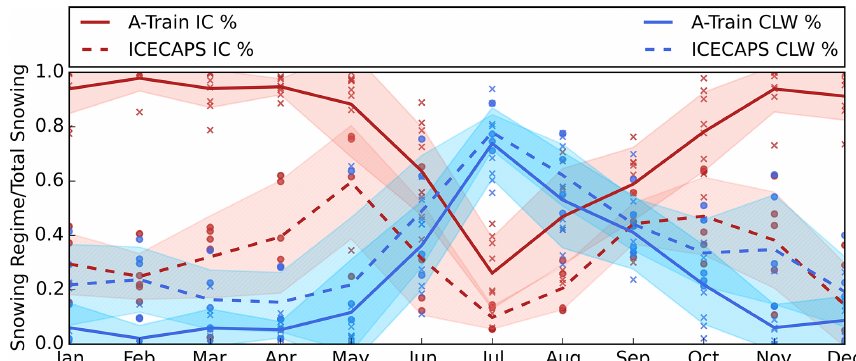
Figure 7. Annual cycle of regime fraction near Summit Station, Greenland. The regime fraction is the number of observations of one of the snowfall regimes (IC or CLW) divided by the total number of snowfall observations. A-Train values (solid lines, “ × ” markers) shown for the near Summit annual cycle line plot are averages for all CPR footprints within 100km of Summit Station, Greenland. The solid lines represent the average of all observational years, with each × depicting a single year’s monthly average. The shaded region surrounding each line is the standard deviation about the mean for the month. The red color is for the IC regime percent and the blue is for the CLW regime percent. For the A-Train data, the red and blue add to 1.0. The ICECAPS values (dashed lines, circle markers) are from vertically pointing instruments at Summit Station, also with markers representing a single year’s monthly average and the line being the mean of all years. The ICECAPS IC and CLW data do not add to 1.0 because of an additional category of “indeterminate” (not